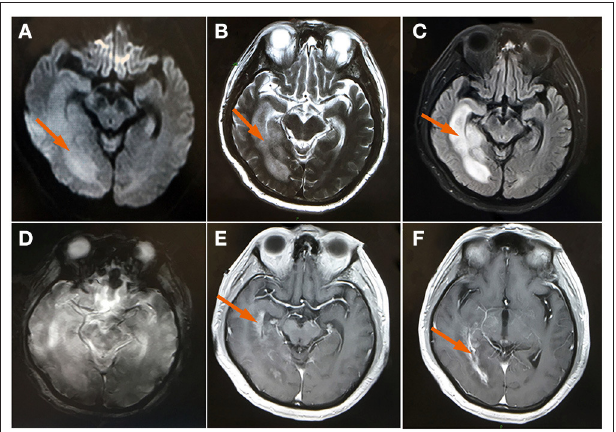
FIGURE 2 | MRI brain (A) Axial DWI and (B) axial T2WI showed a high signal and the size of the edematous area showed a marked increase at the right temporal occipital lobe (arrow); (C) FLAIR image showed a swollen, edematous temporal occipital lobe (arrow); (D) axial GRE sequence at the same level with the high signal of T2WI; (E,F) A contrast-enhanced image demonstrated an abnormal enhancement of the right temporal occipital lobe and bilateral choroid (arrow). DWI, diffusion-weighted imaging; FLAIR, fluid-attenuated inversion-recovery; GRE, gradient echo image; T2WI, T2 weighted